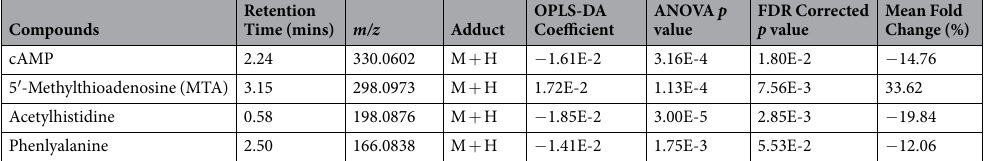
Table 3. List of identified Biomarkers.